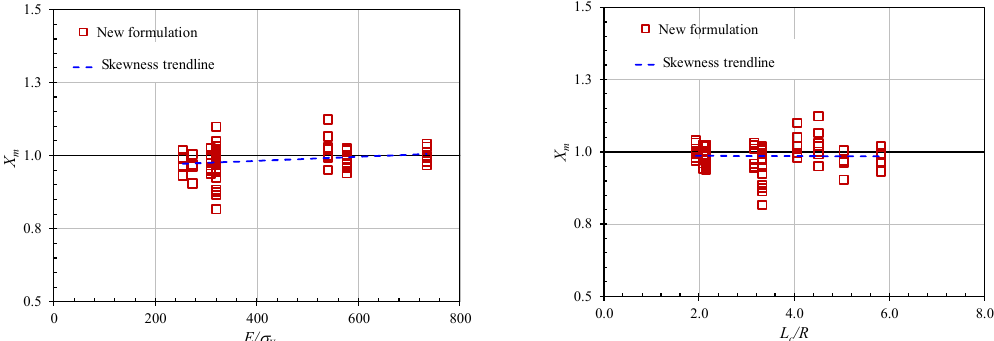
Figure 23. Skewness of the proposed formula against the basic parameters h w /t w and w f /t f for the ring- stiffened cylinder.